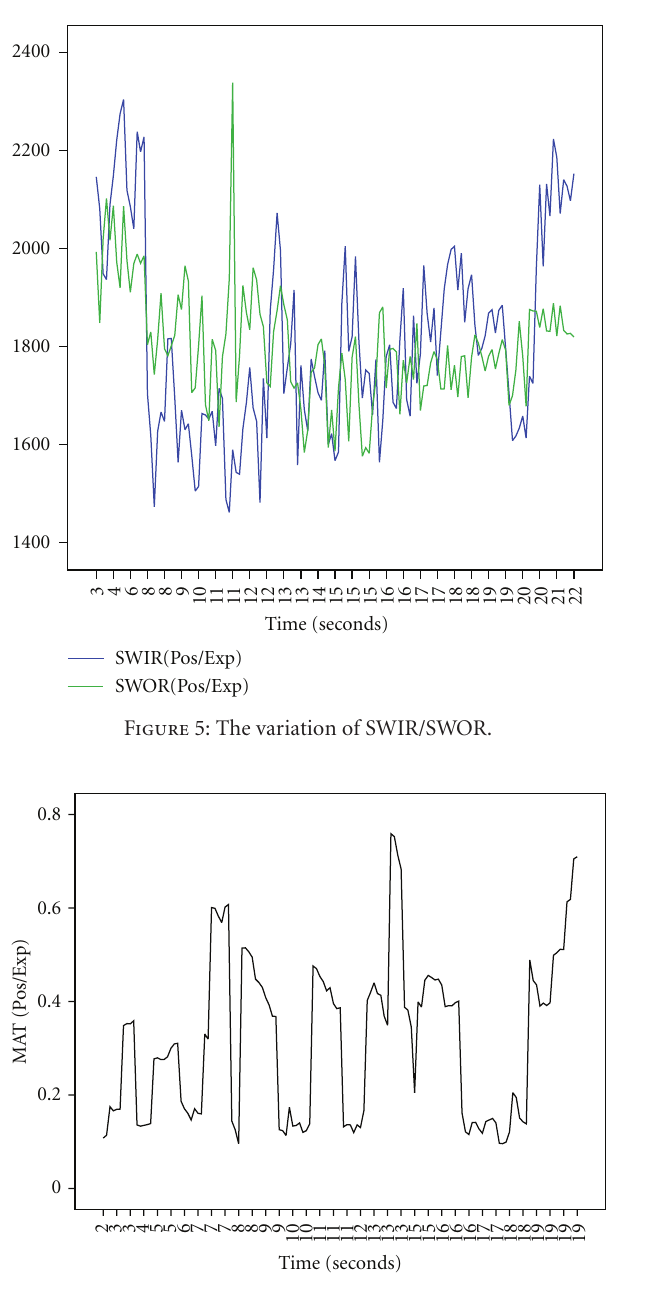
Figure 6: The variation of MAT.